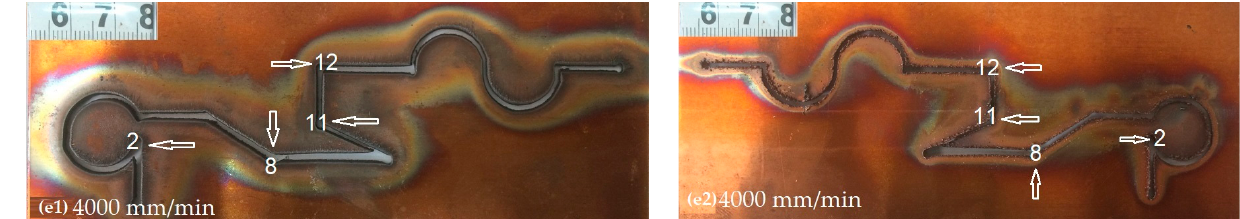
Figure 7. The c utting path width of ( e1 , e2 ) at 4000 mm/min at 30 A for Point 2.